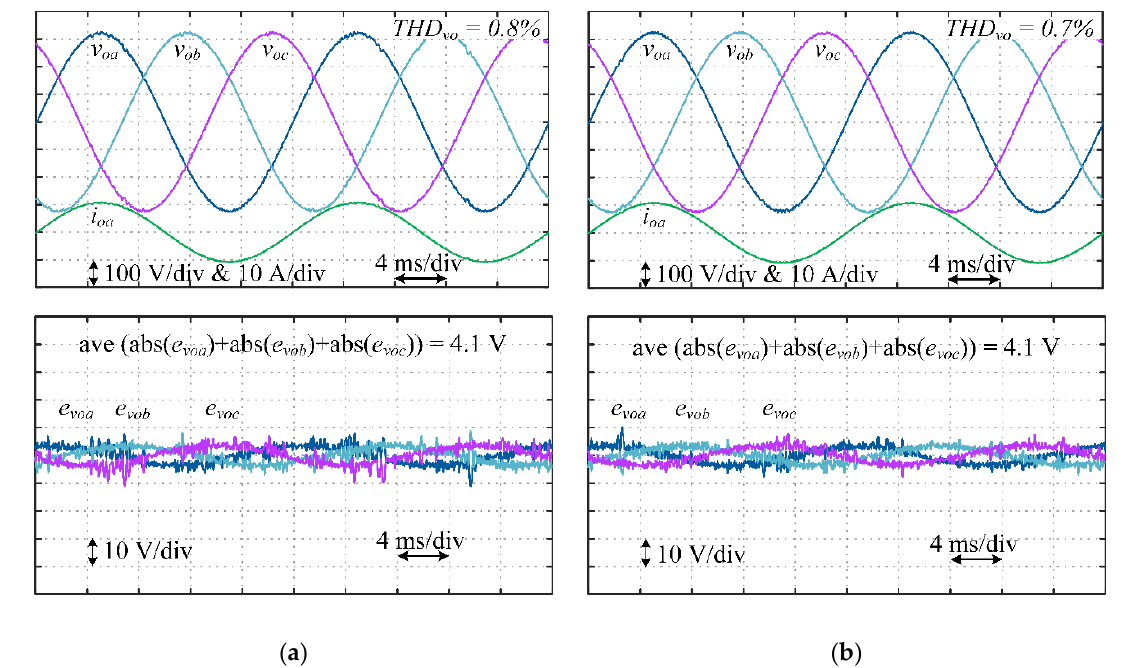
Figure 3. Simulation results showing steady-state performance under nominal linear load (5 kW), ( a ) the proposed adaptive MPC, ( b ) conventional MPC.